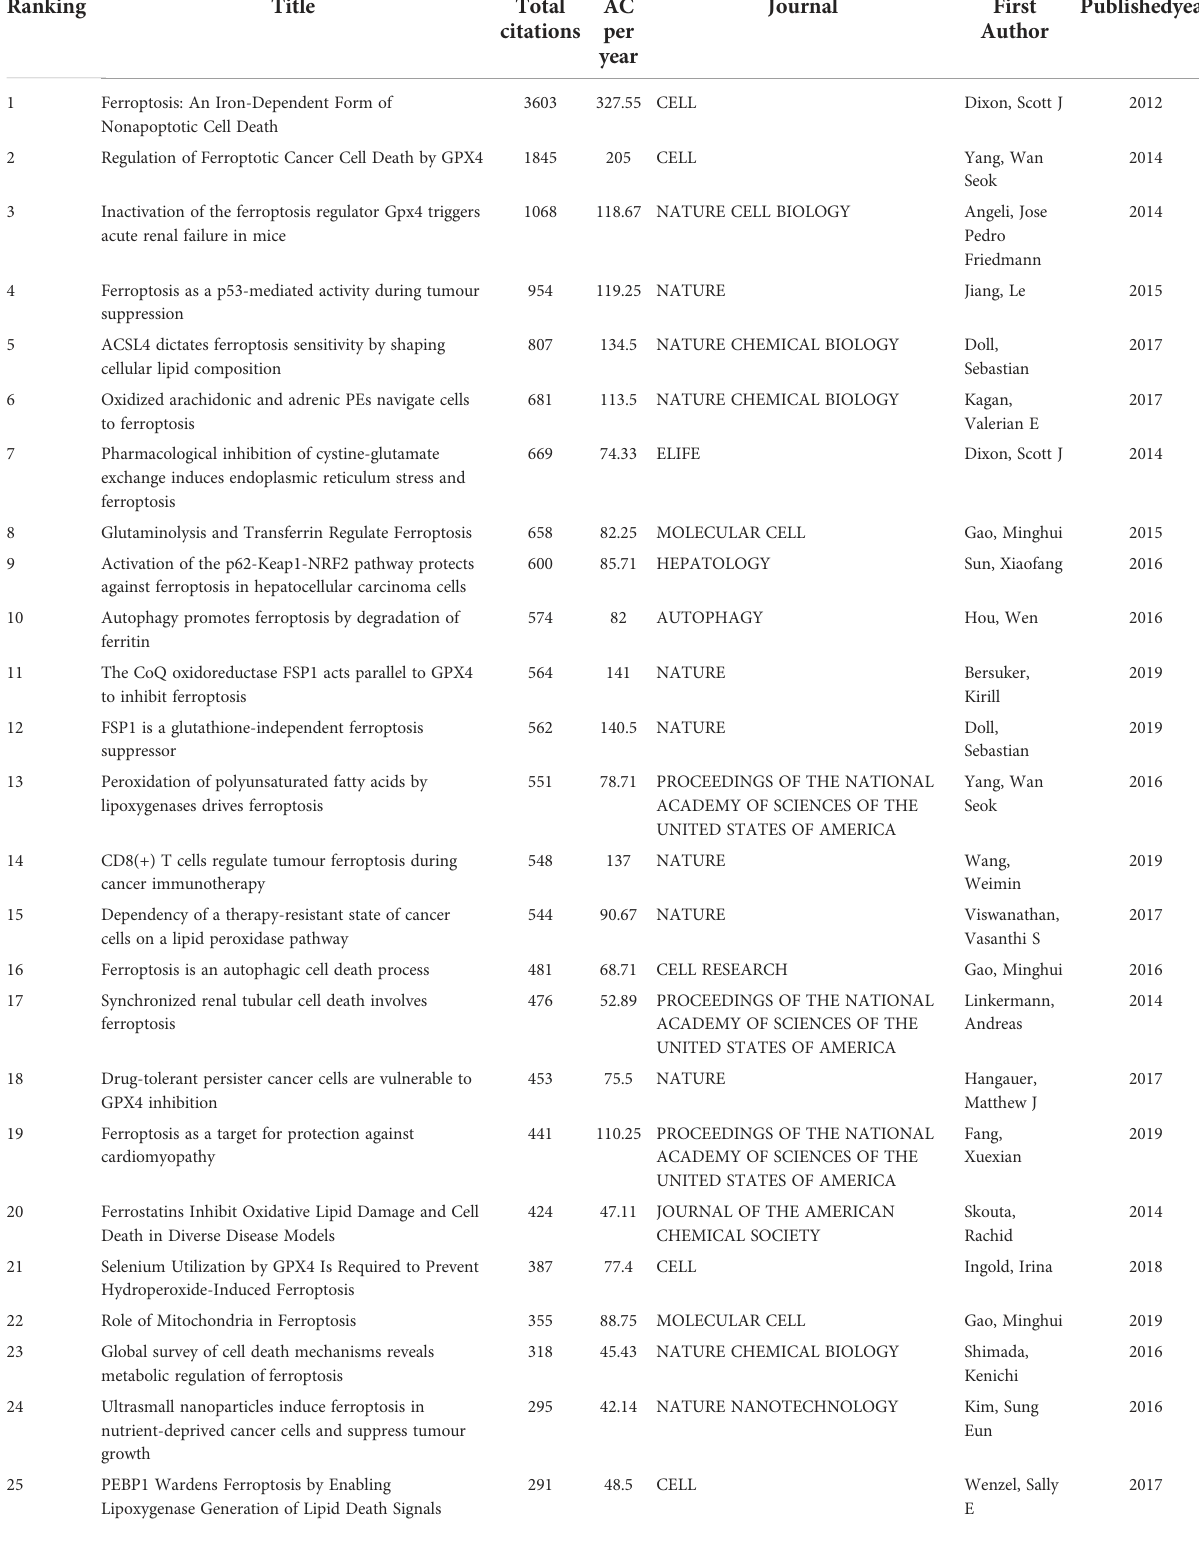
TABLE 1 Top 100 highly cited articles on ferroptosis ranked according to their total citations counts.